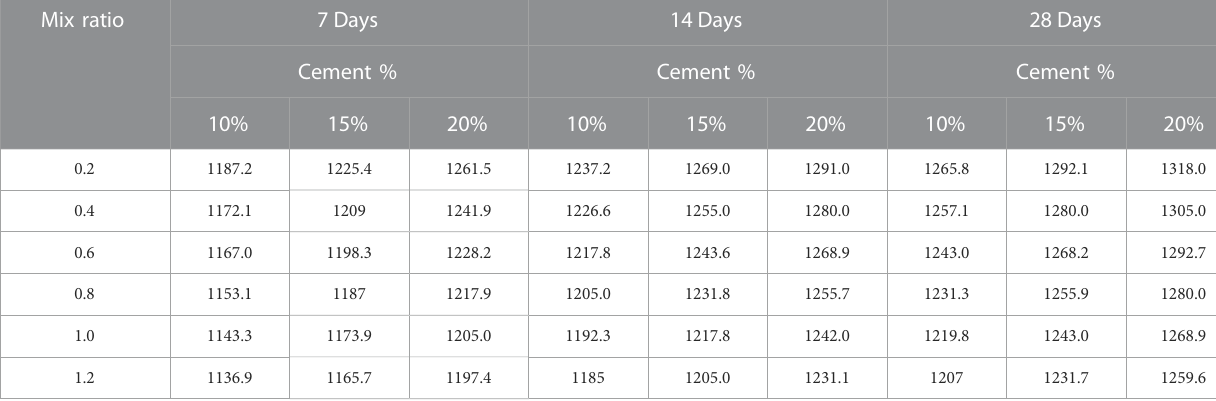
TABLE 3 Density of beam materials after 7, 14, and 28 days for 10%, 15%, and 20% cement to SA materials. Mix